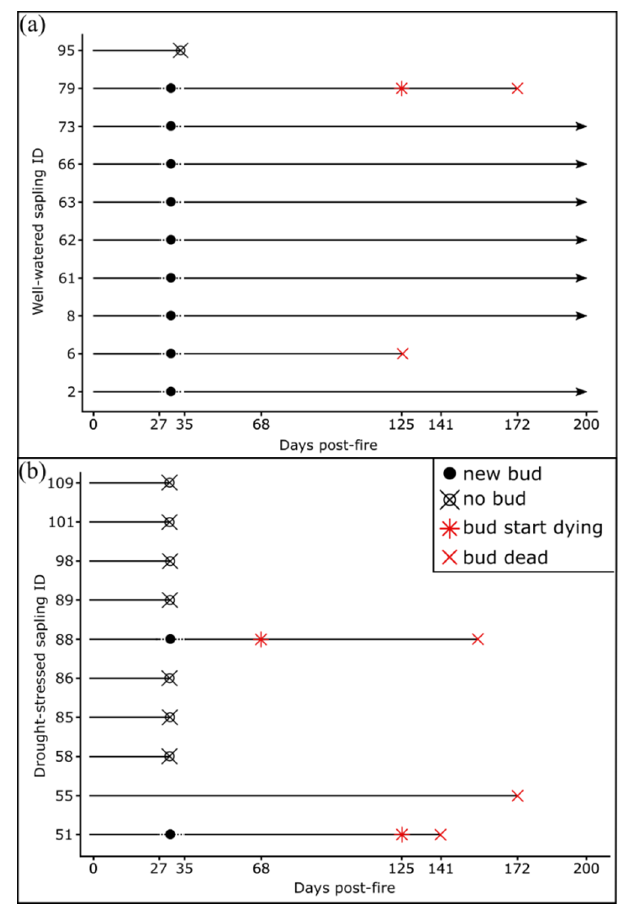
Figure 2. Bud emergence, development and mortality of ( a ) well-watered and ( b ) drought-stressed Pinus ponderosa saplings burned at 0.7 MJ m −2 . All saplings burned at 1.4 MJ m −2 did not have ‘new buds’ by day 35 post-fire. ‘New buds’ indicates saplings with at least one flushed bud between day 27 and 35, ‘bud start dying’ indicates buds where new leaves started turning brown and ‘bud dead’ indicates buds where all the new leaves died. All saplings were watered one day before day 0. The drought-stressed sapling ID 55 burned at 0.7 MJ m −2 did not flush any new buds but retained some green foliage post-fire.